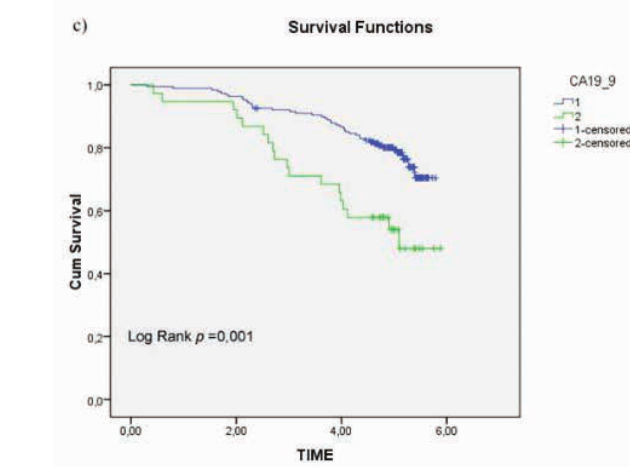
Figure 2a: Overall Survival (OS) according to histological grading (G1 and G2 vs. G3, p =0.017).